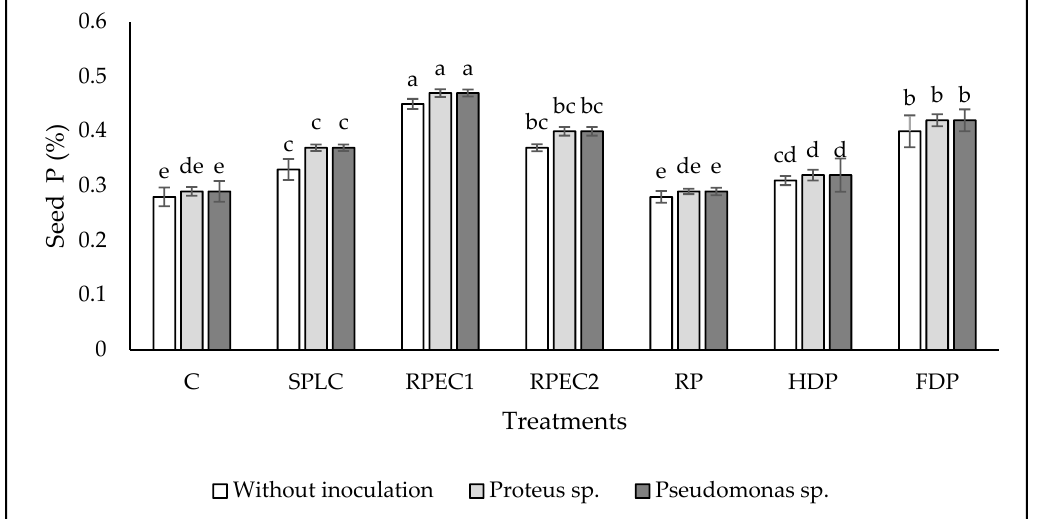
Figure 5. Effects of PGPR, P-enriched compost and inorganic fertilizers on plant P uptake (kg ha -1 ) in wheat. C- Control; SPLC-Poultry litter only; RPEC1-Rock phosphate + poultry litter solubilized with Pseudomonas sp. during the composting process; RPEC 2 -Rock phosphate + poultry litter solubilized with Proteus sp. during composting process), RP-Rock phosphate + poultry litter; HDP- Half dose inorganic P from Single Super Phosphate-SSP 18% P 2 O 5 ; FDP- Chemical fertilizer (Single Super Phosphate). All the treatments sharing common letter are similar otherwise they differ significantly at p ≤ 0.05.